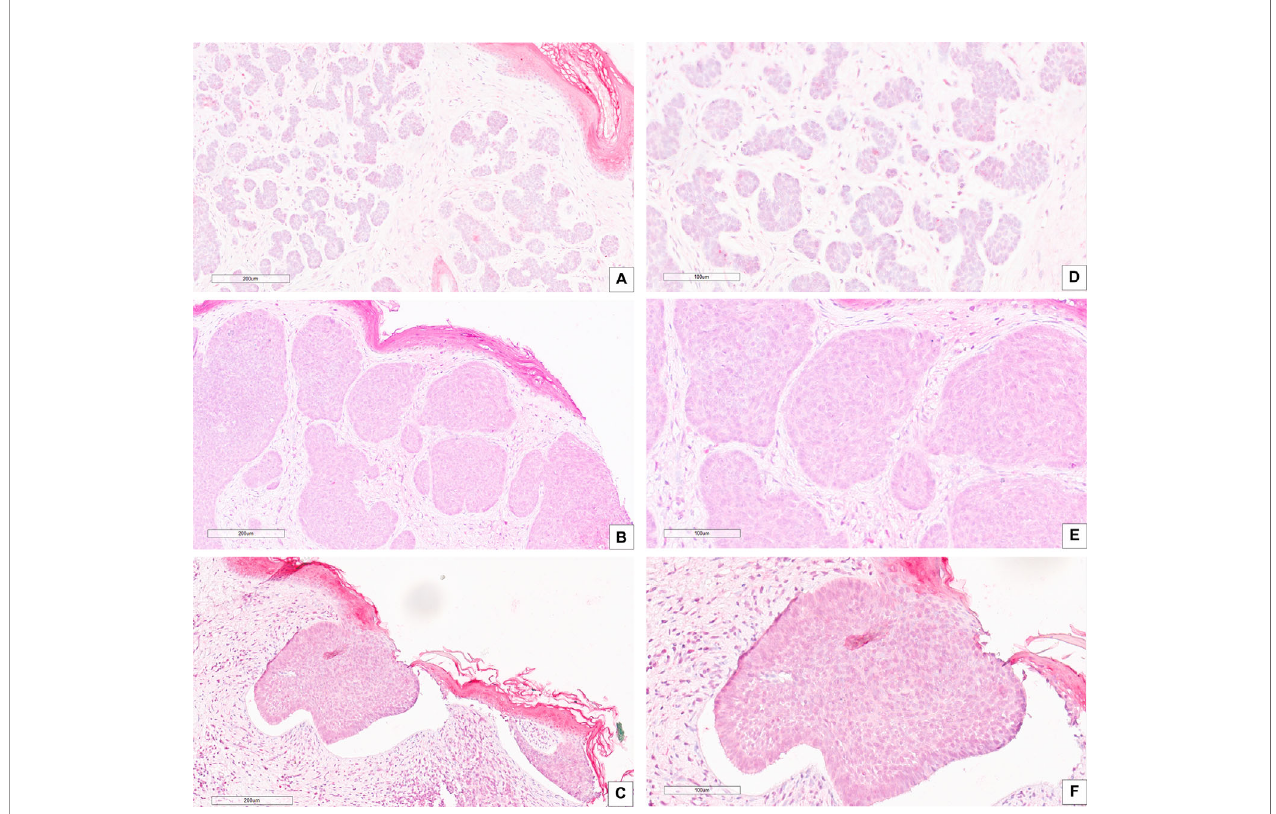
FIGURE 2 | IHC stain with an anti-CAIX antibody in low risk BCC histological variants: (A – D) BCC with adnexal differentiation (magni fi cation, 20× and 40×, respectively); (B – E) Nodular BCC (magni fi cation, 20× and 40×, respectively); (C – F) Super fi cial BCC (magni fi cation, 20× and 40×, respectively). Scale bars are shown.